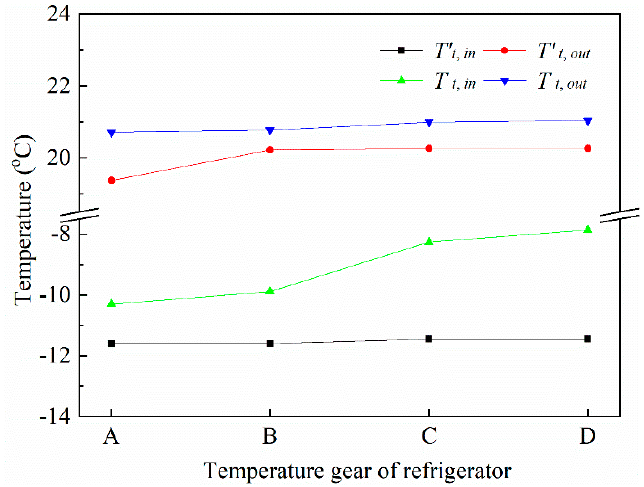
Figure 9. Surface temperatures of the side freezer wall versus temperature gear.